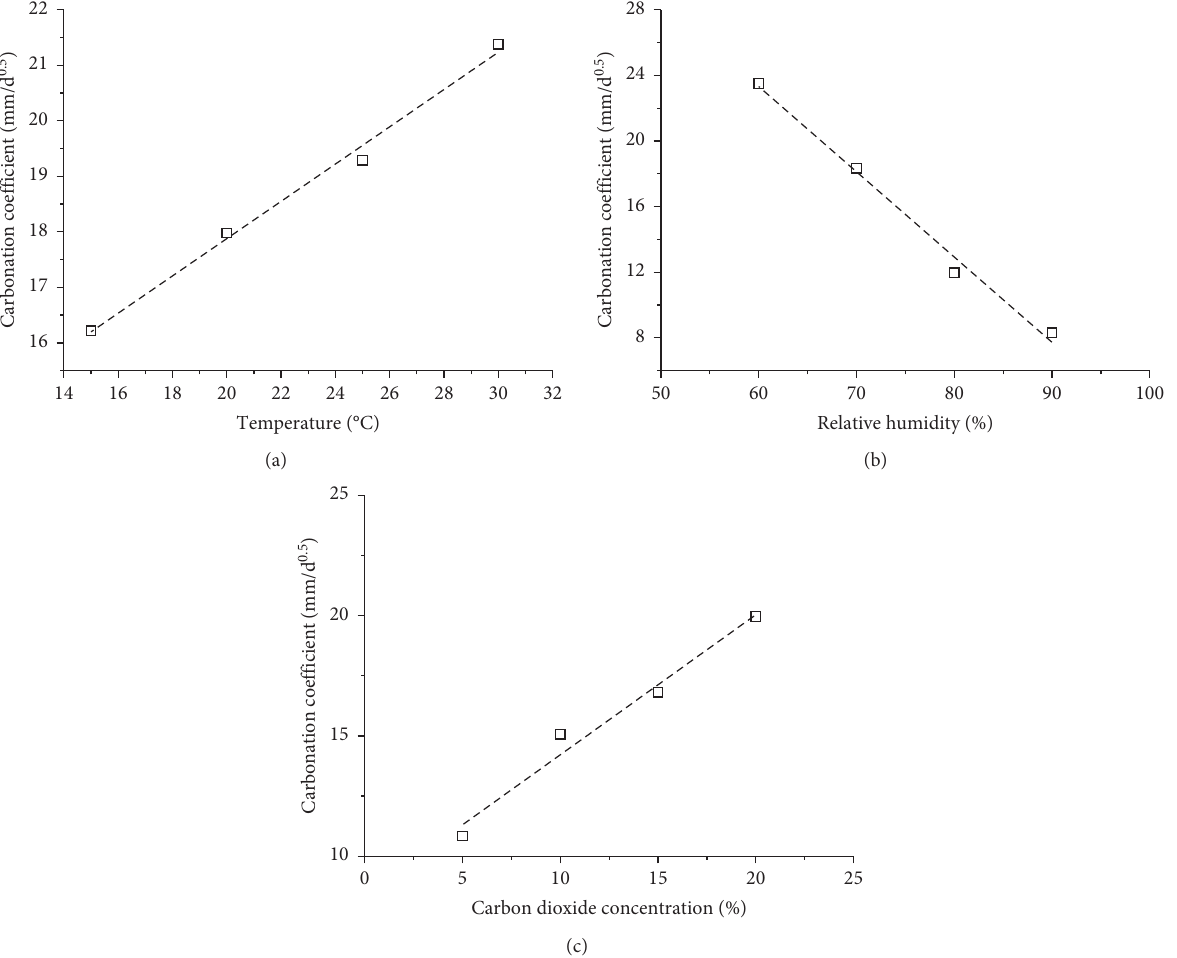
Figure 8: Relationships between carbonation coefficient and (a) temperature, (b) relative humidity, (c) carbon dioxide concentration.